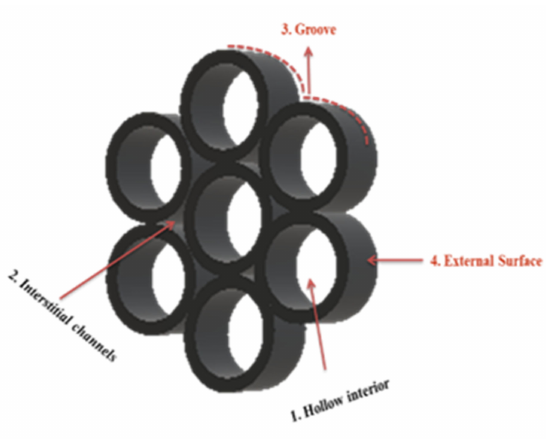
Figure 2. Possible active adsorption sites on the carbon nanotubes (CNT)